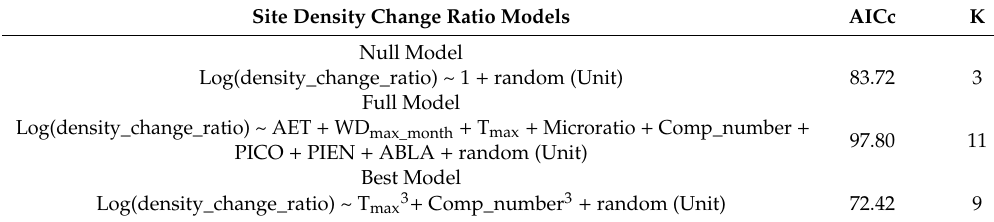
Table 7. Mixed e ff ects models of site density change ratio (AET = mean annual cumulative actual evapotranspiration, WD max_month = maximum monthly water deficit, T max = maximum monthly site temperature, Micro ratio = ratio of microsite presence / absence, Comp = mean number of competitors within 3.59m radius, PICO = ratio of Pinus contorta presence or absence within plot, PIEN = ratio of Picea Engalmanii presence or absence within plot, ABLA = ratio of Abies lasiocarpa presence or absence within plot).